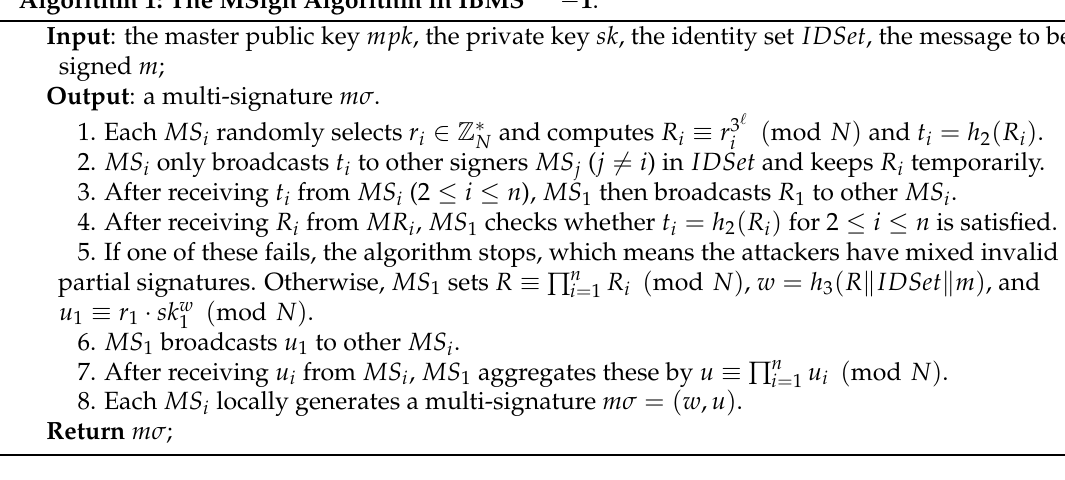
Algorithm 1: The MSign Algorithm in IBMS CR − 1